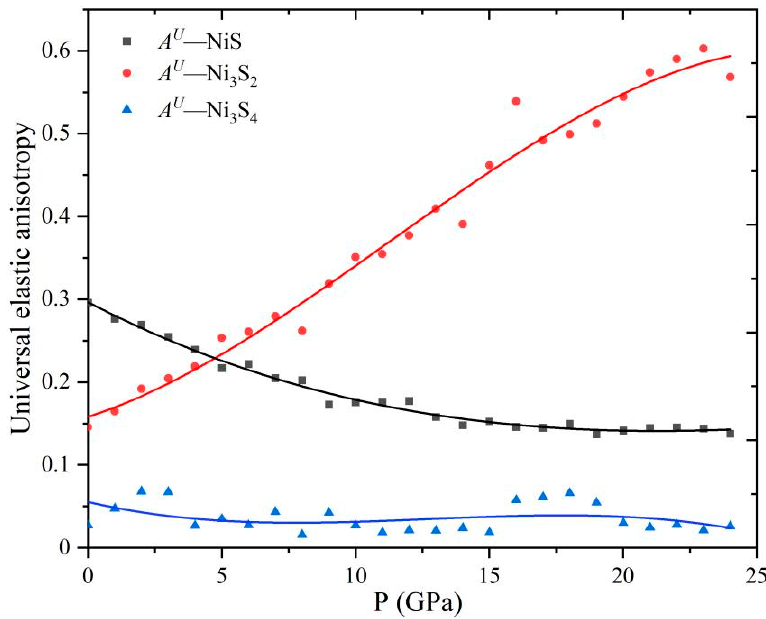
Figure 5. The universal elastic anisotropic index ( A U ) of millerite, heazlewoodite, and polydymite as a function of pressure.